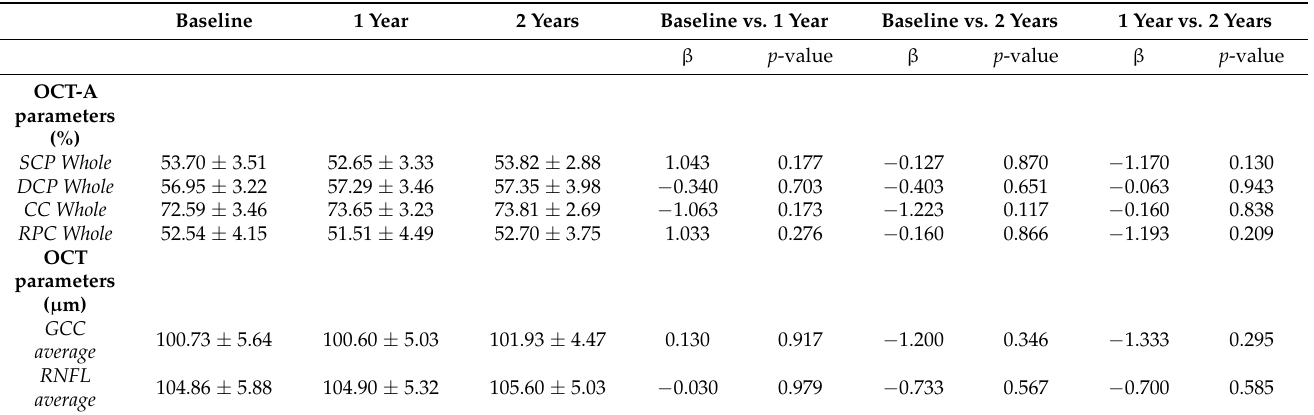
Table 2. Clinical characteristics of healthy controls at baseline and each time